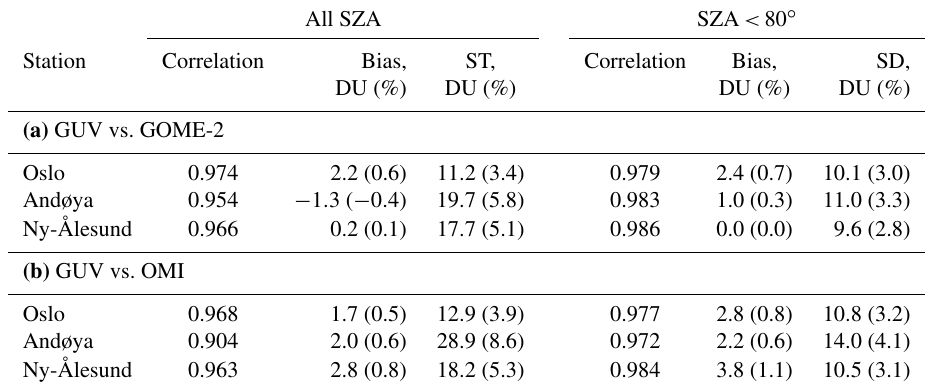
Table 5. Correlation, bias, and SD in daily noontime total ozone from (a) GUV vs. GOME-2 for 2007–2019 and (b) GUV vs. OMI for 2004–2019. Bias and SD are both expressed in DU and percent (in parenthesis). All SZA Correlation Bias,